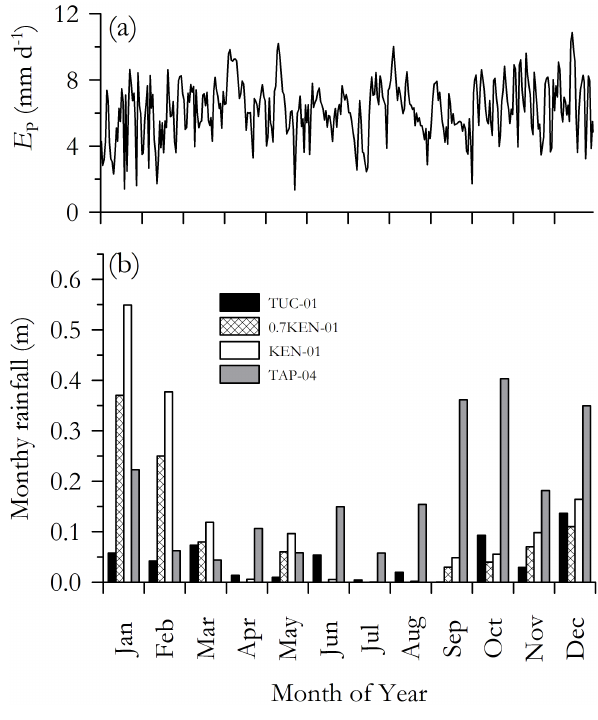
Figure B1. Key temporally varying inputs as used in the simula- tions (a) potential evapotranspiration (shown as daily totals) and (b) precipitation (shown as monthly